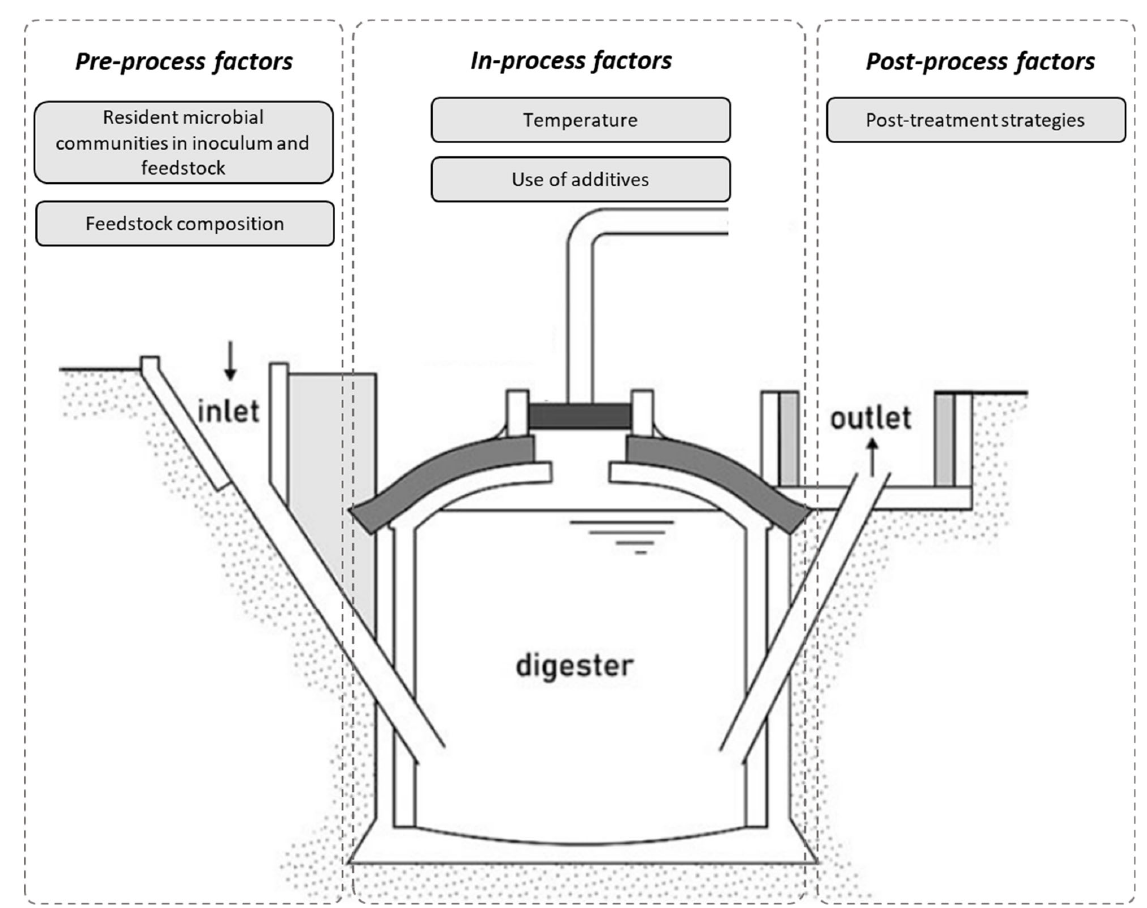
Figure 1. Factors that contribute to the microbial composition of